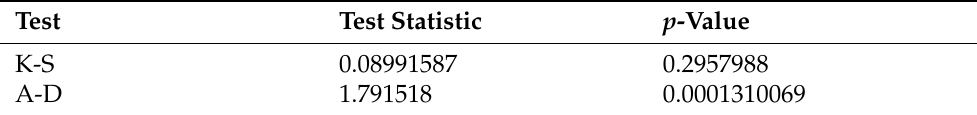
Table 14. Goodness-of-fit for Mpumalanga